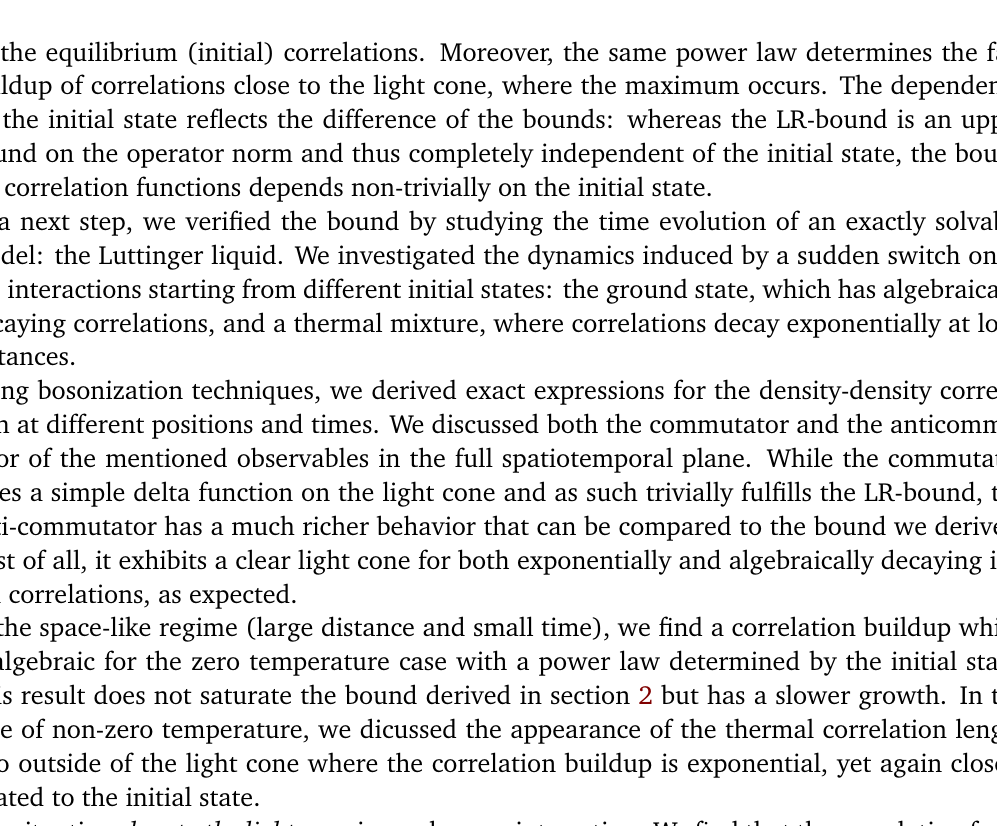
Figure 4: Spatiotemporal behavior of the non-equal-time anticommutator | C ( x , t , t ) | for T = 0 and t /ν = 40 without the initial contributions. The anti- + 0 0 commutator takes on the form of a double light cone: the signal on the diagonal is the stationary decay which propagates further if t > t . A horizontal cut through the 0 ) /ν = 30 is shown on the right (Fig. 4b). Due to different signs plot for time ( t − t 0 ) ν = 30 and ( t + t ) /ν = 110 cancel exactly the two light cone contributions at ( t − t 0 0 in the middle of the peaks. We again see an algebraic decay regime outside of the outer light cone. This is directly related to the initial correlations (see